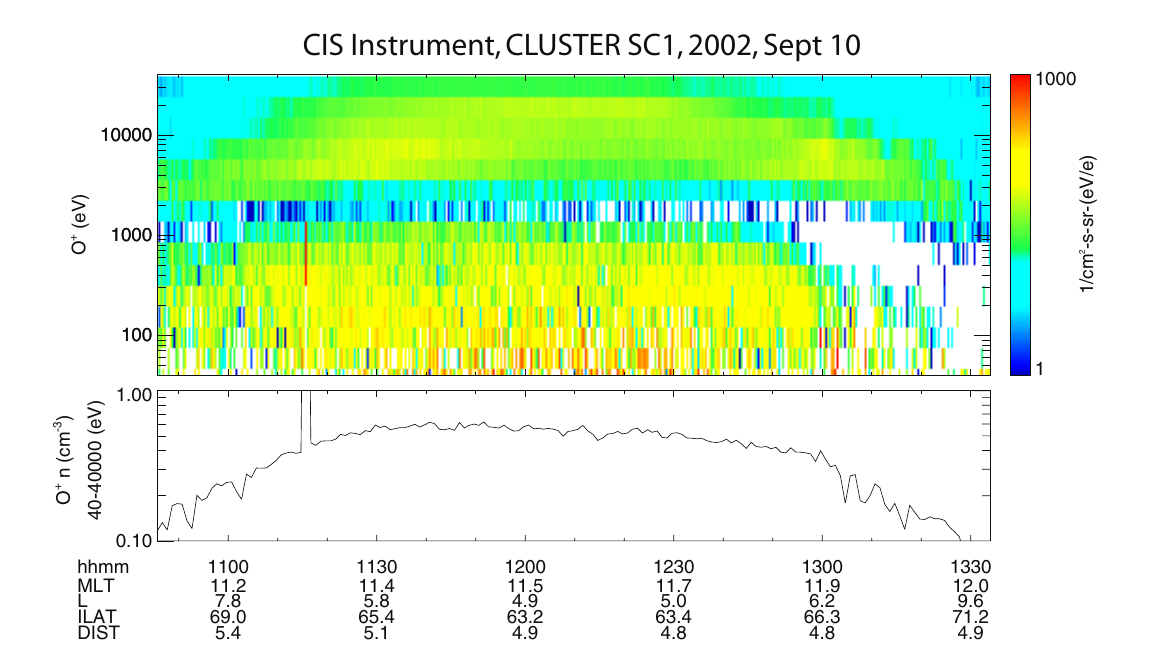
Fig. 14. (Top) Spectrogram of the flux of O+ ions with energy from 40eV to 40keV, and (bottom) density of O+ integrated over the same energy range for the 10 September 2002